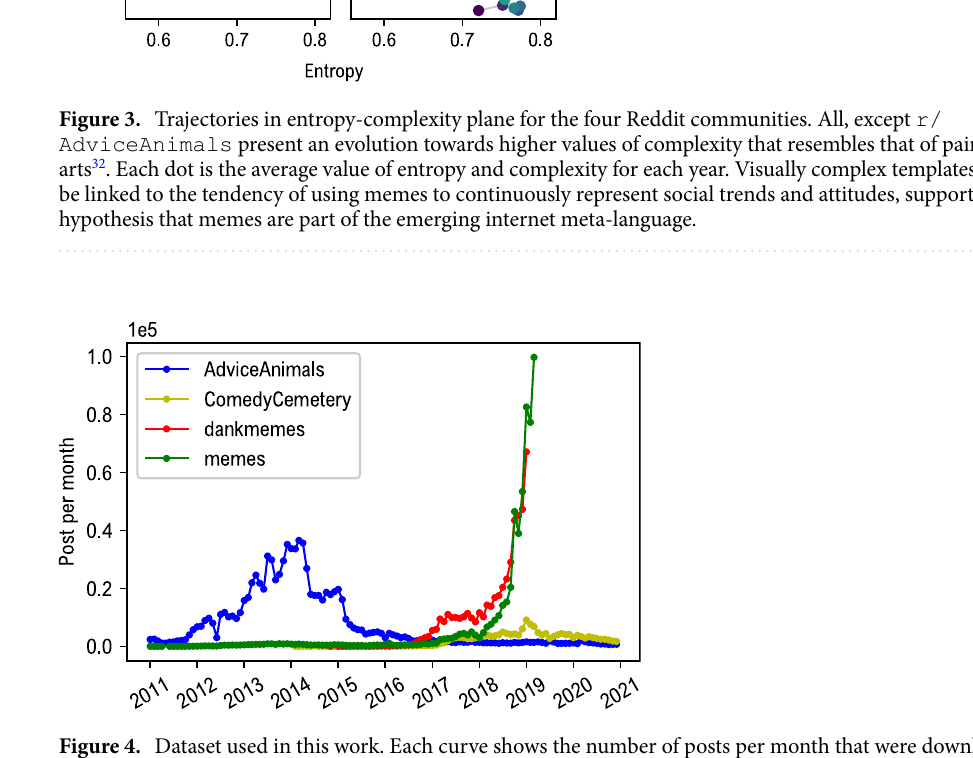
Figure 4. Dataset used in this work. Each curve shows the number of posts per month that were downloaded from Reddit. Each posts correspond to an image. The total amount of downloaded memes is about 2